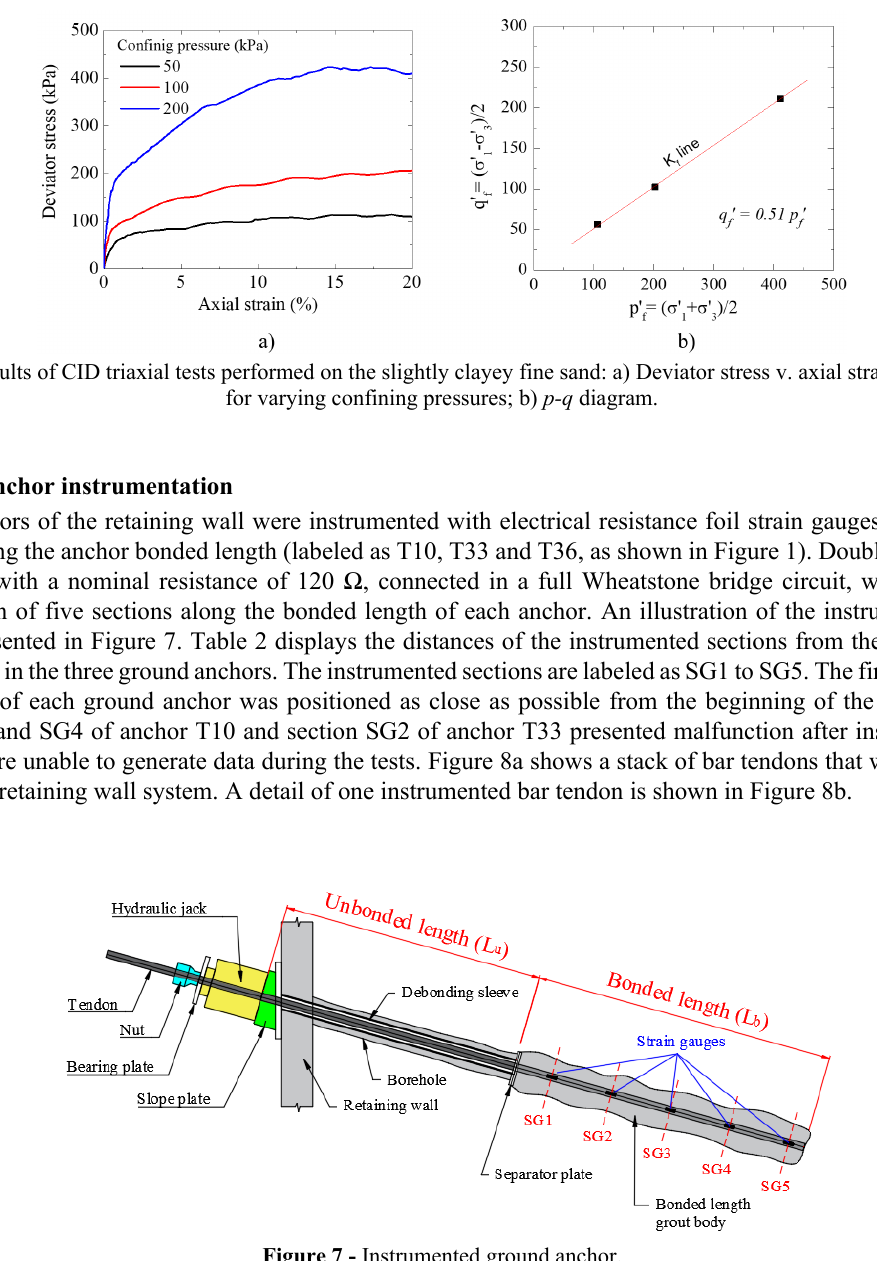
Figure 7 - Instrumented ground anchor.